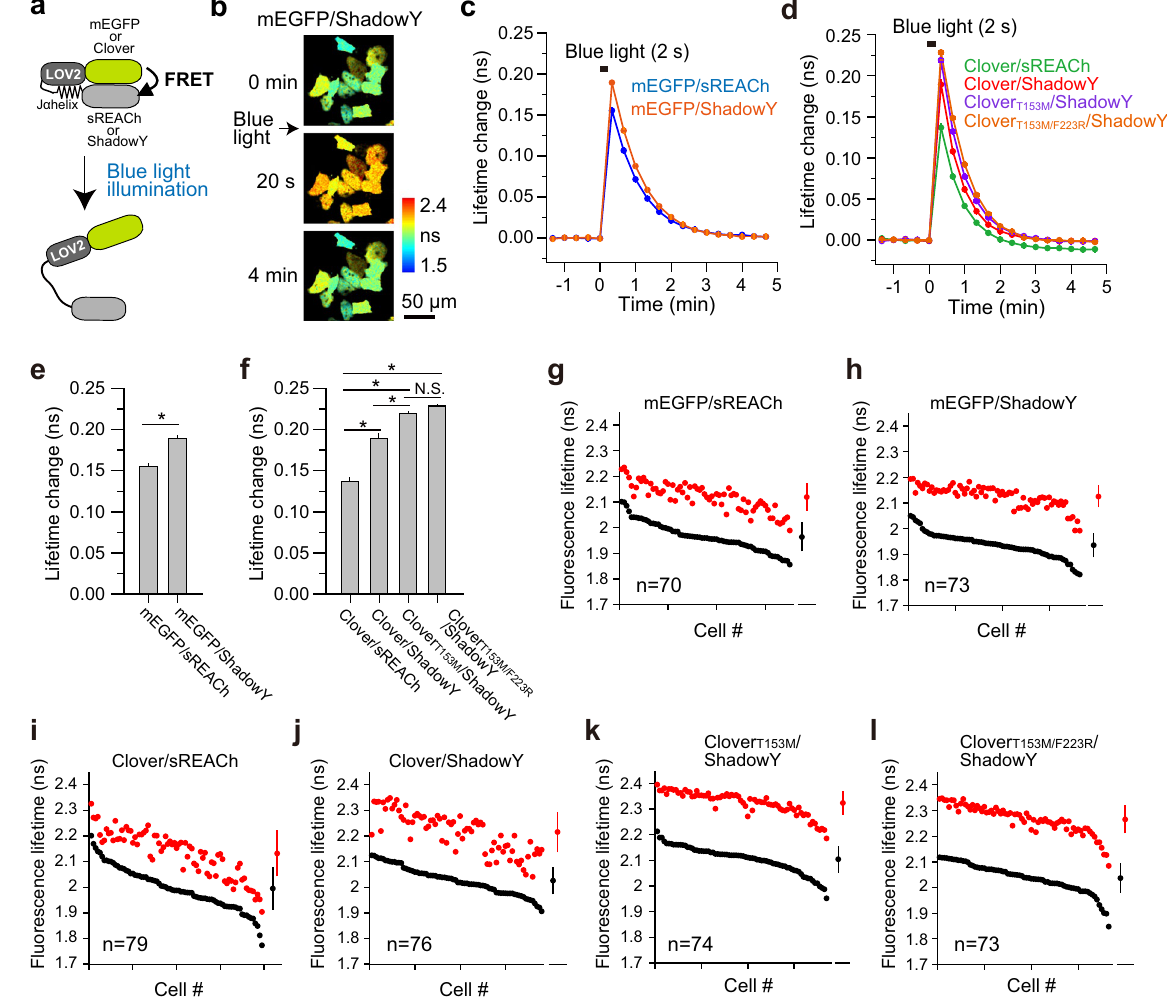
Figure 4. Performance of ShadowY in LOV2 FRET sensors in HeLa cells. ( a ) A schematic of a conformational change of the light-sensitive LOV2 FRET sensors. ( b ) Representative fluorescence lifetime images of mEGFP- LOV2-ShadowY after blue light illumination for 2 seconds at 35 mW/cm 2 . The scale bar is 50 µ m. ( c ) An averaged time course of fluorescence lifetime changes in response to blue light illumination. The number of cells analyzed is 70 for mEGFP–sREACh and 73 for mEGFP–ShadowY. The data are presented as mean ± SEM. ( d ) An averaged time course of fluorescence lifetime changes in response to blue light illumination. The number of cells analyzed is 79 for Clover–sREACh, 76 for Clover–ShadowY, 74 for Clover T153M –ShadowY, and 73 for Clover T153MF223R –ShadowY. The data are presented as mean ± SEM. ( e , f ) The fluorescence lifetime changes at 20 sec after blue light illumination were quantified using the data presented in ( c , d ), respectively. The data are presented as mean ± SEM. Asterisks denote statistical significance (p < 0.05, analysis of variance [ANOVA] followed by Scheffé’s post hoc test). N. S. = not statistically significant. ( g–l ) The lifetime changes in individual HeLa cells before and after light illumination (the same dataset as in panels c and d). The basal fluorescence lifetime (averaged over − 1.3 to 0 min) of individual cells is plotted in the descending order (black) along with the corresponding fluorescence lifetime values (at 20 sec) after blue-light illumination (red). The data are also presented as mean ± SD on the right. The number of samples (n) is indicated in respective